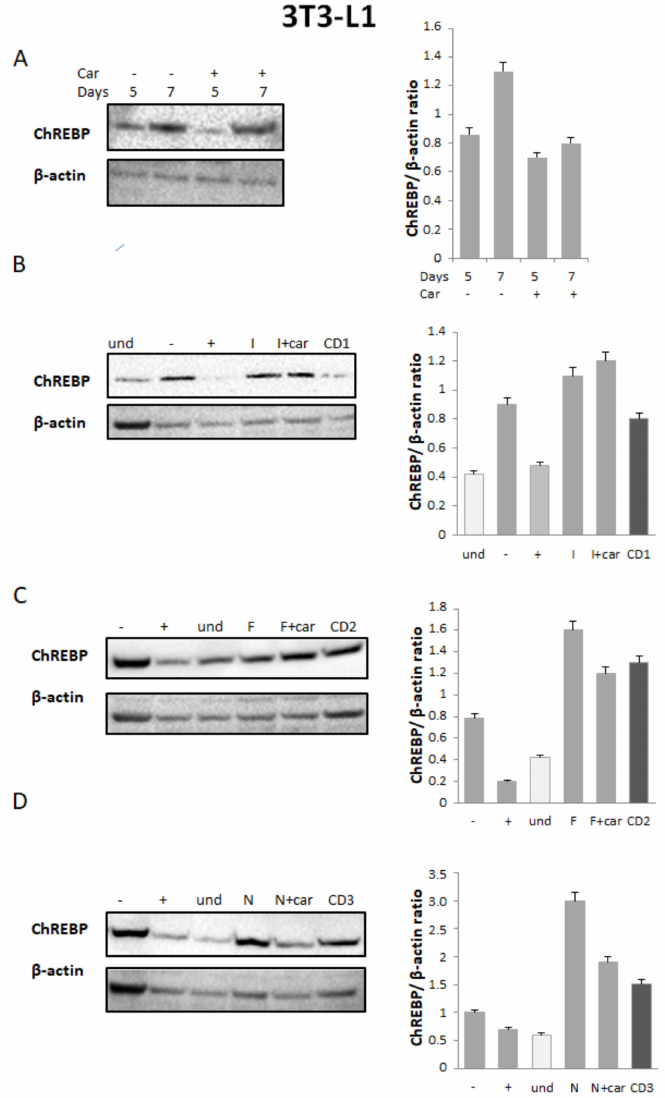
Figure 3. Effect of CD1-3 on ChREBP activity during the adipogenic process. ( A ) Western blot and densitometric analysis of ChREBP in 3T3 cells undergoing adipogenic differentiation for, respectively, 5 to 7 days without (diff − Car) or with (diff + Car) 25 µ M Car; ( B – D ) Western blot and densitometric analysis of ChREBP in 3T3-L1 cells undergoing adipogenic differentiation for 7 days without ( − Car) or with (+Car) 25 µ M Car; NSAID alone (I = Ibuprofen, F = Flurbiprofen, N = Naproxen); a physical mixture of selected NSAID and 25 µ M Car; and CD1-3 . Anti- β -actin was used as the protein loading control. Bars depict the means ± SE. ( n =